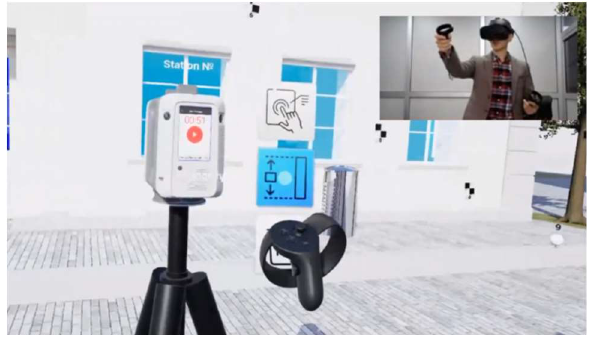
Figure 3. Operating simulator in Oculus Rift S VR